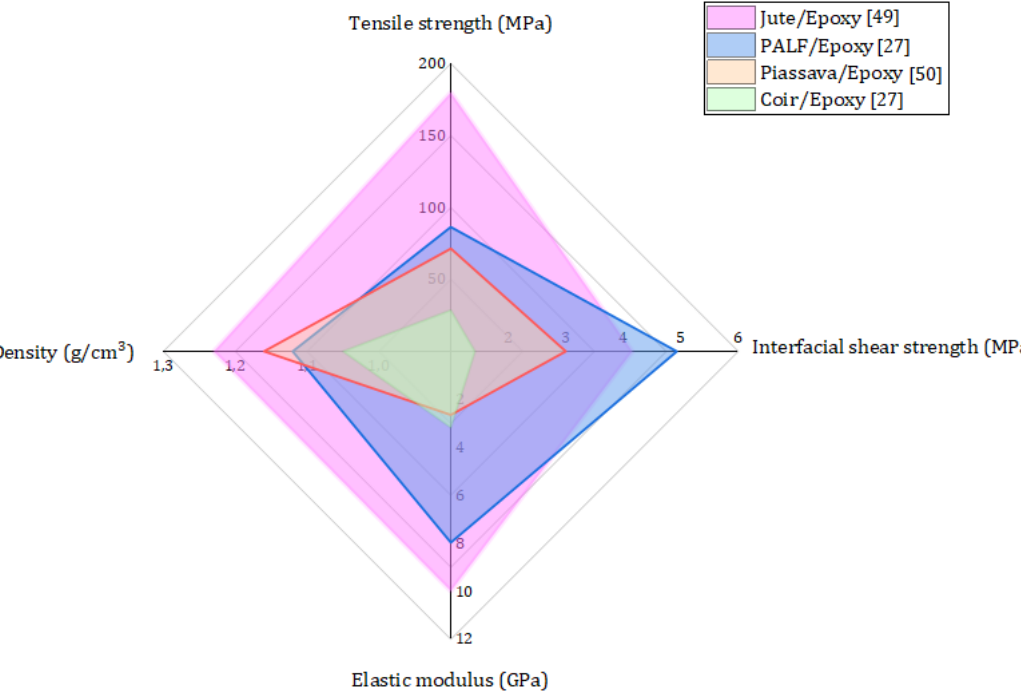
Figure 6. The comparison of physical and mechanical properties between PALF / epoxy [27], jute / epoxy [49], piassava / epoxy [50], and coir / epoxy [27] composites (illustration done by the authors).